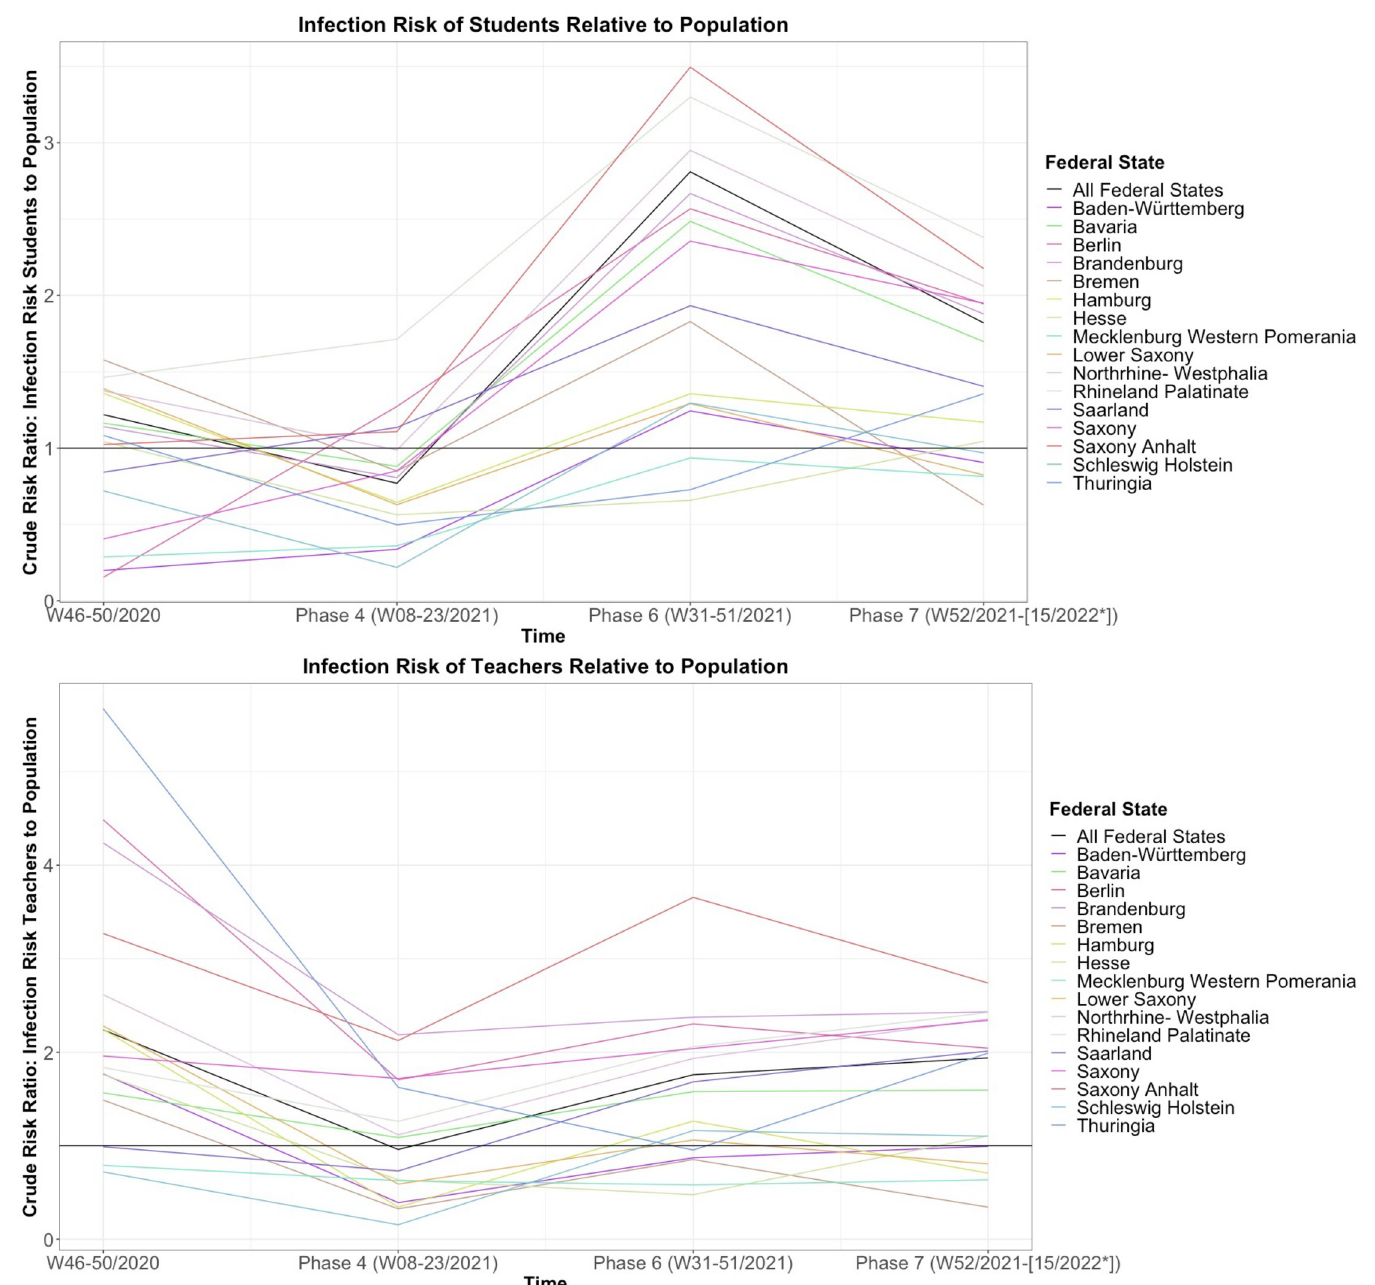
Fig 2. AU : AbbreviationlisthavebeencompiledforthoseusedinFigs 2 to 5 : Pleaseverifythatallentriesarecorrect : CRR of (A) students to population and (b) teachers to population. CRR of infection of students (A) and teachers (B) compared to the infection risk of the population in the respective federal state and time interval, based on NUTS-2 level data by the KMK. A crude risk ratio of 1 indicates equal risk of infection. � End of phase 7 not yet defined, data collection by KMK ceased W15/2022. As phase 5 covers the summer plateau and summer vacation it has not been included in this graphic due to data paucity. All data in Table G in S1 File. Phase 4 VOC alpha, phase 6 VOC delta, phase 7 VOC omicron. CRR, crude risk ratio; VOC, variant of